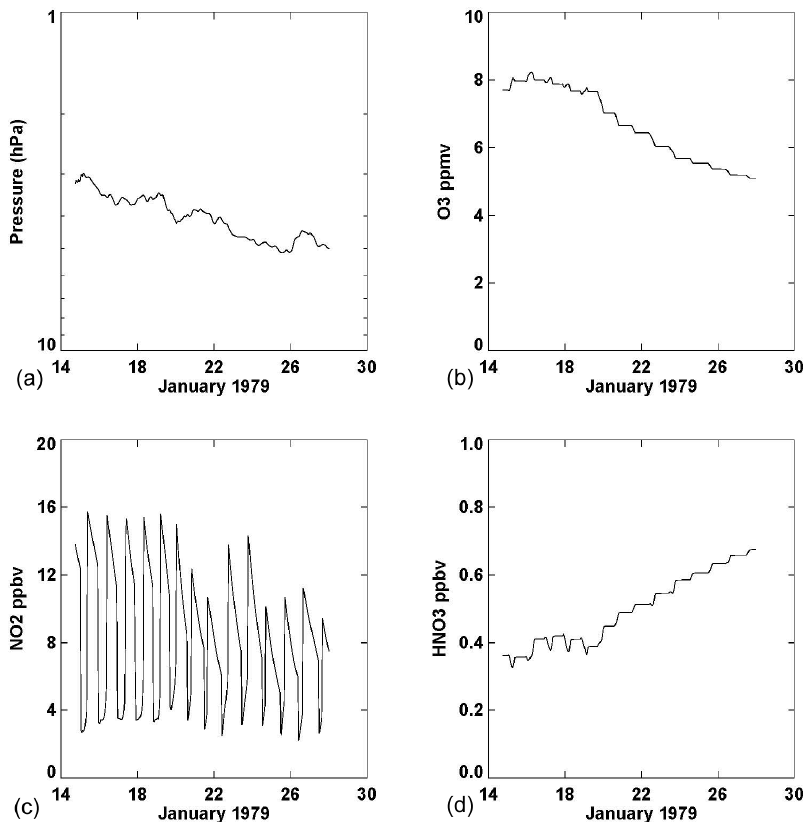
Figure 12. Air parcel history of the changes in its (a) pressure, (b) ozone, (c) NO 2 , and (d) HNO 3 .